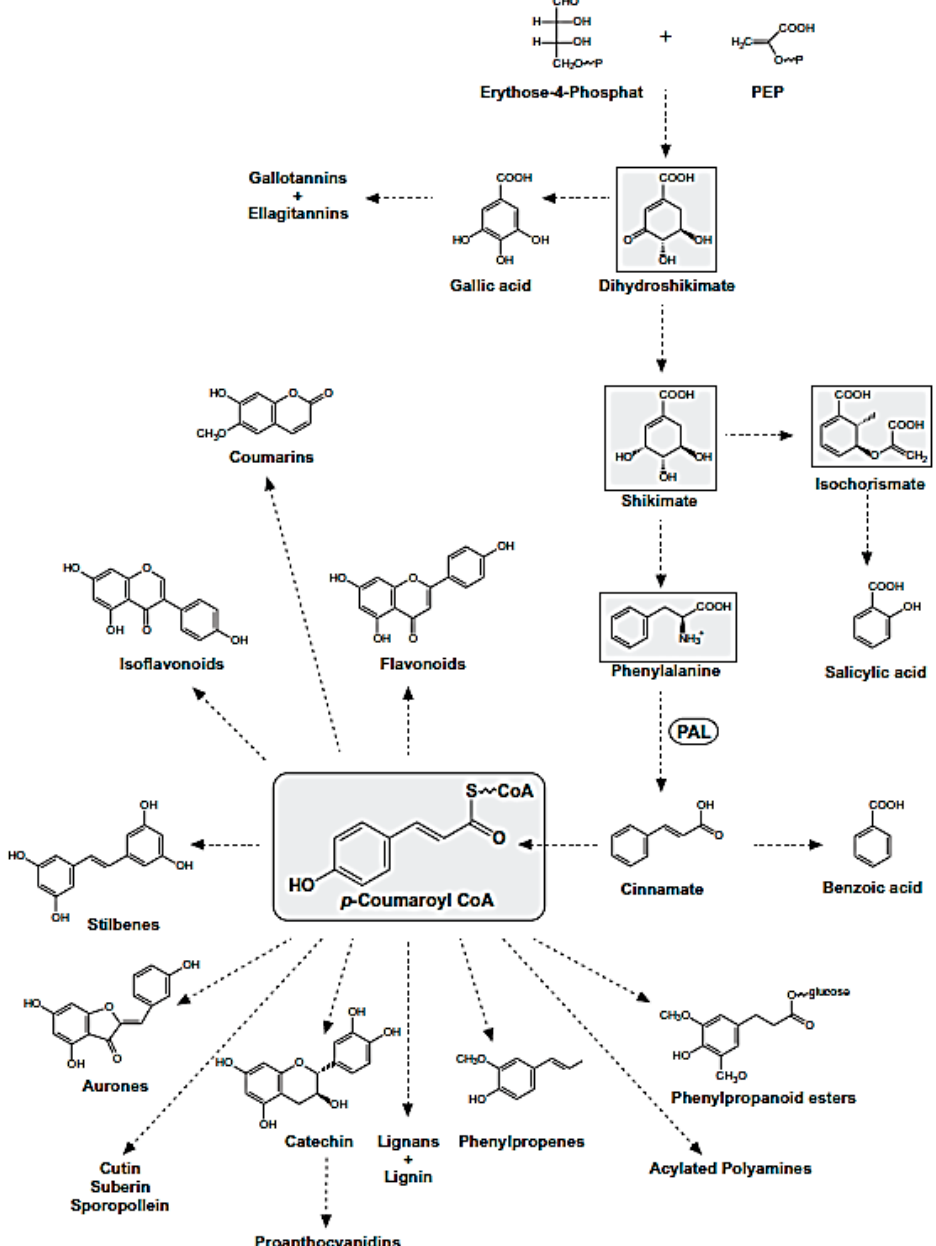
Figure 7. Phenylpropanoid Pathway. The metabolites of the shikimate pathway and p-coumaroyl CoA are shaded in grey.